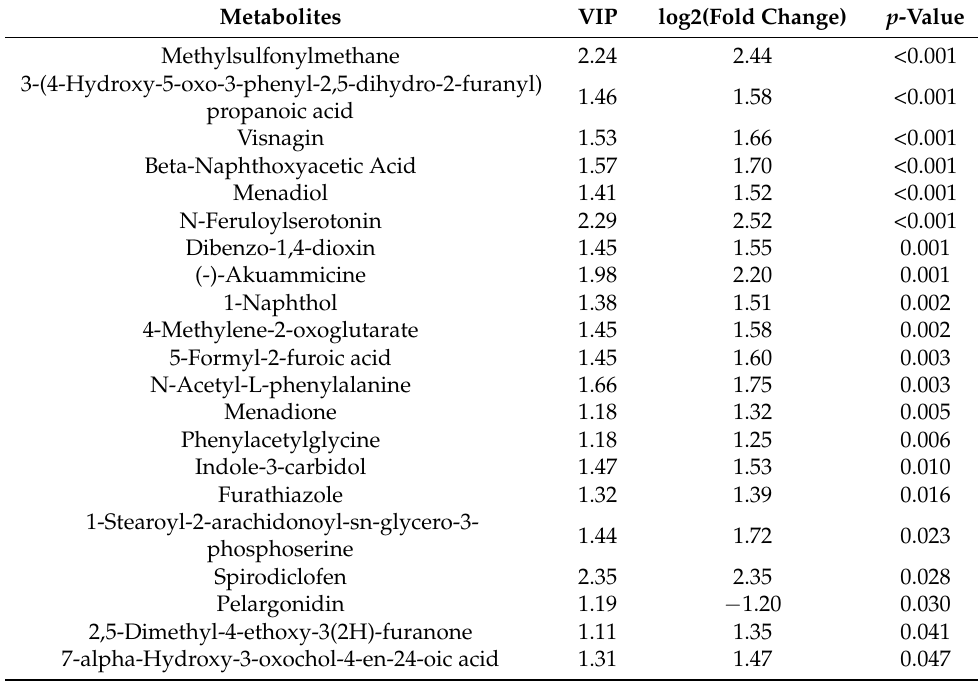
Table 4. The positive ion pattern of differentially expressed metabolites with VIP > 1 and p < 0.05 in the plasma of piglets exposed to G. elegans based on ANOVA.